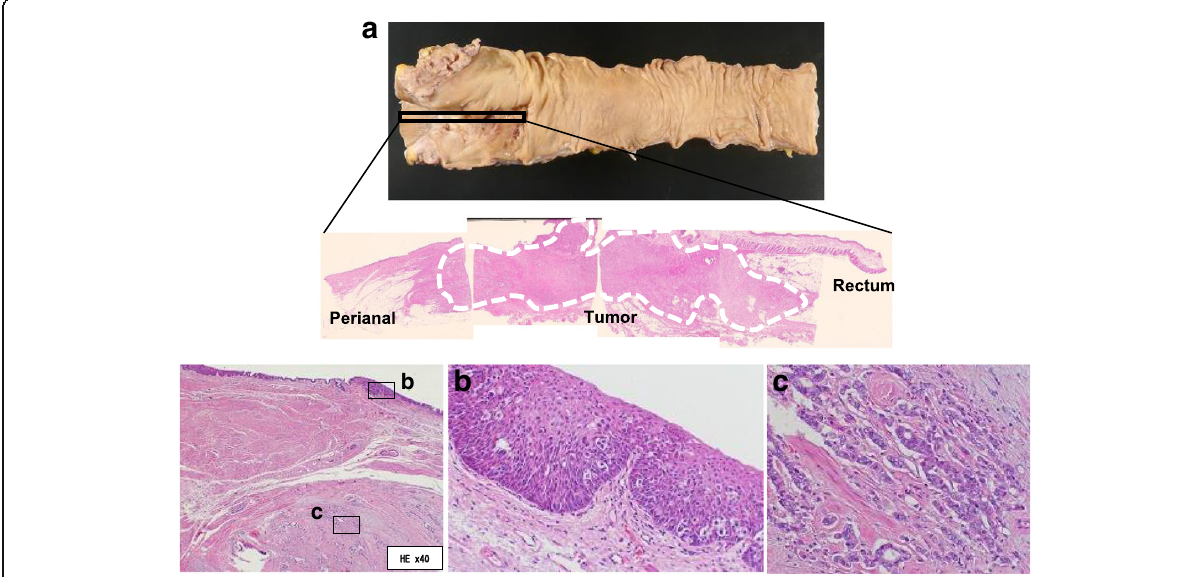
Fig. 4 The tumor lesion occupied the perianal region and rectum, with internal anal sphincter invasion ( a ). Many Paget cells ( arrow head ) were observed in the squamous epithelium ( b ). There were moderately to poorly differentiated adenocarcinoma cells in the submucosal layer ( c